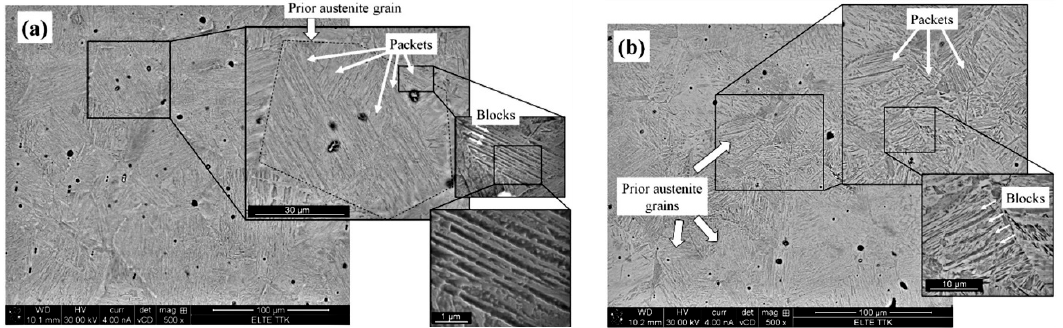
Figure 5. ( a,b ) Scanning electron micrographs showing the prior austenite grain encircled by thin black lines, the packets in the first enlarged rectangle, and the blocks in the further enlarged rectangles. The black spots are contaminations on the surface, not belonging to the structure.